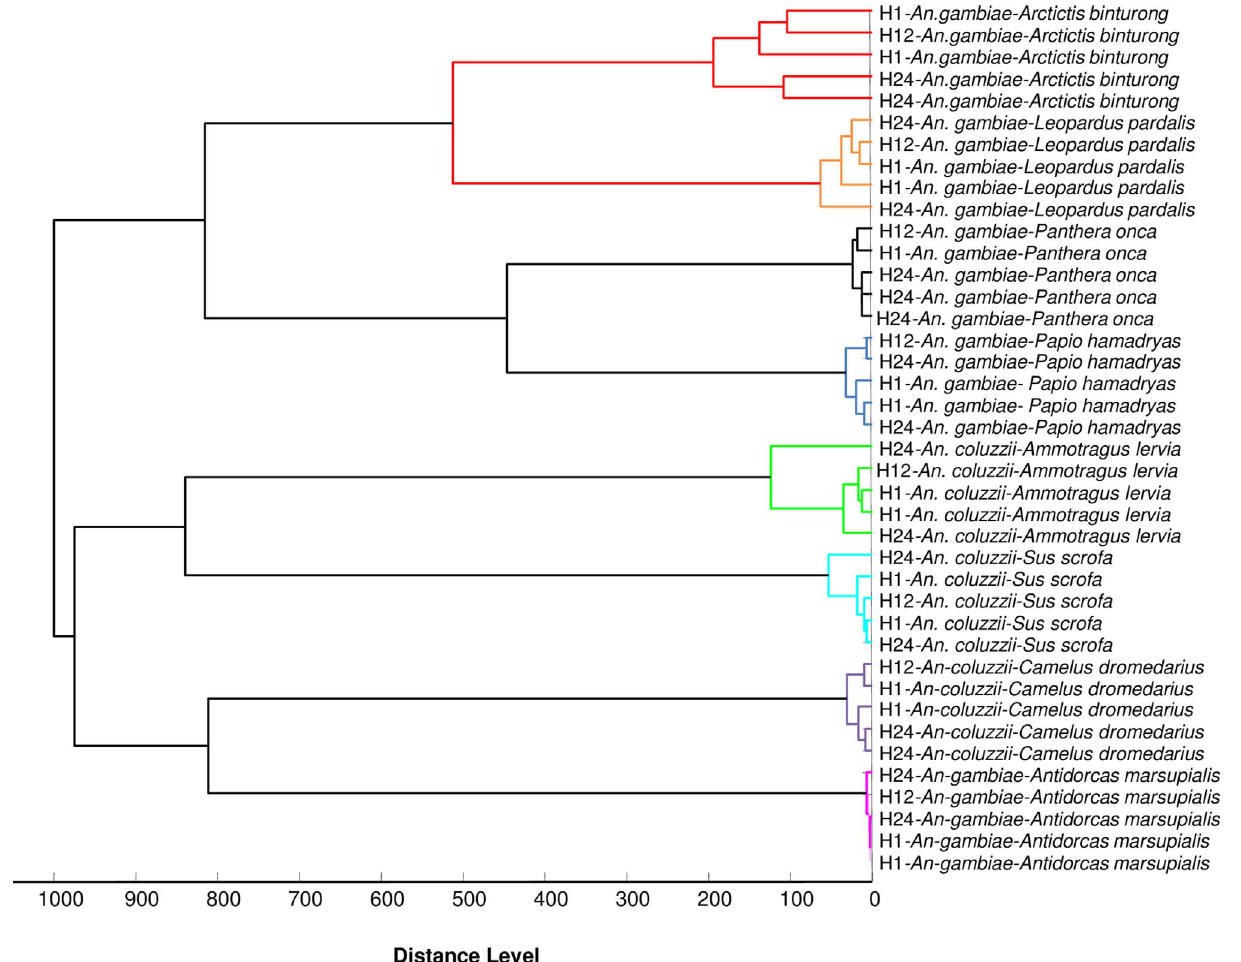
Figure 3. MSP dendrogram of MALDI-TOF MS spectra from Anopheles gambiae Giles and Anopheles coluzzii abdomens collected 1, 12 and 24 h post-feeding. MS spectra from two specimens from 1 to 24 h post-feeding and one specimen from 12 h post-feeding are represented. Blood meal host origins are indicated in the graph. Cluster analysis was performed by MALDI-Biotyper software